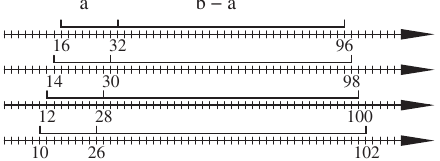
Figure 4. Domains From Which a and ( b – a ) Are